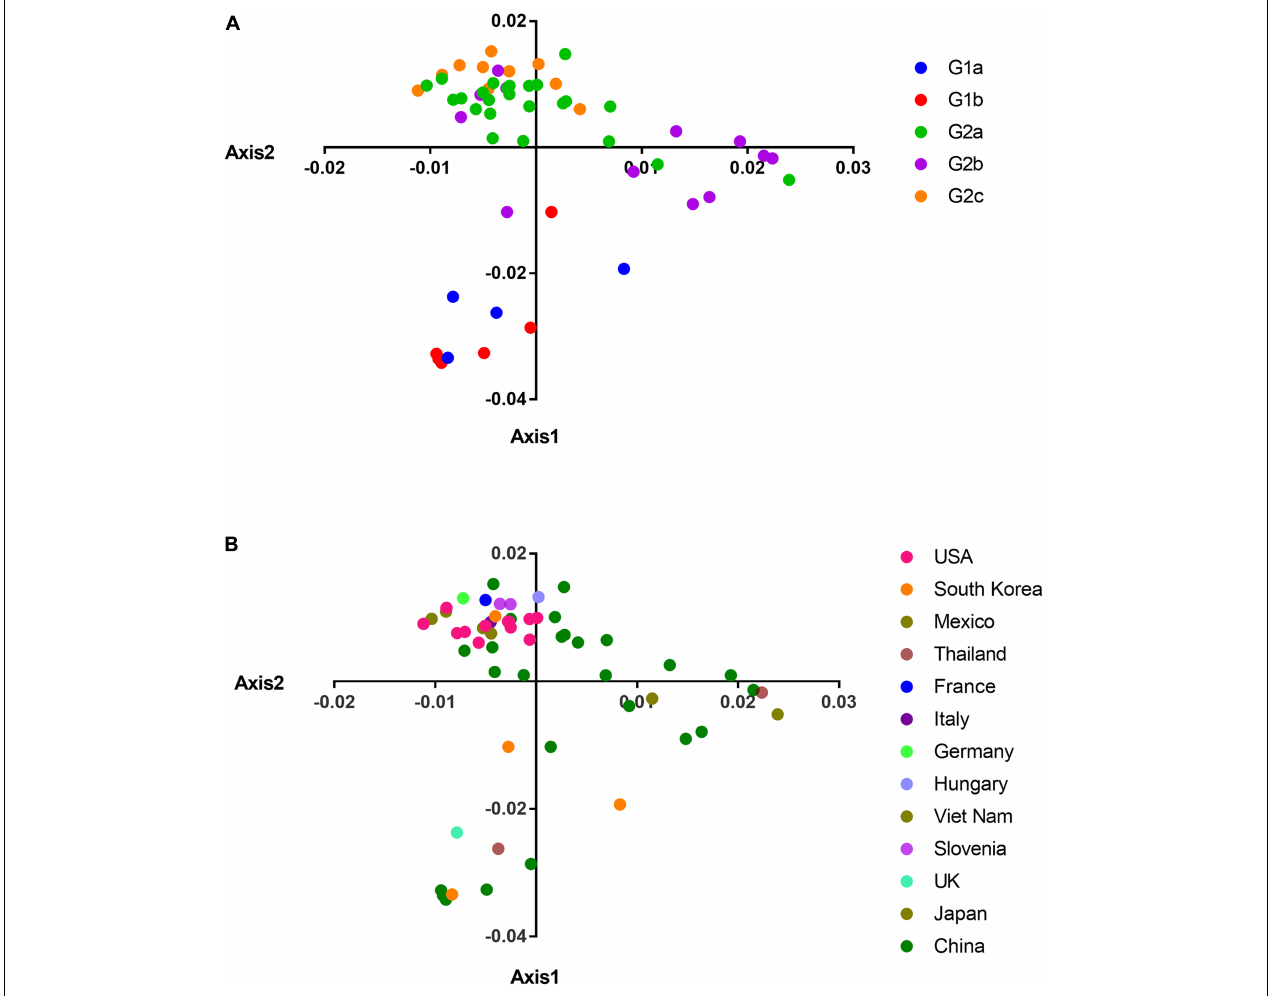
FIGURE 3 | COA on the RSCU values. (A) PCA plot according to separate clades. (B) PCA plot data according to country. The clades and countries are represented in different color. The analysis was based on the RSCU value of the 59 synonymous codons. The positions of each virus were described in the first two main-dimensional